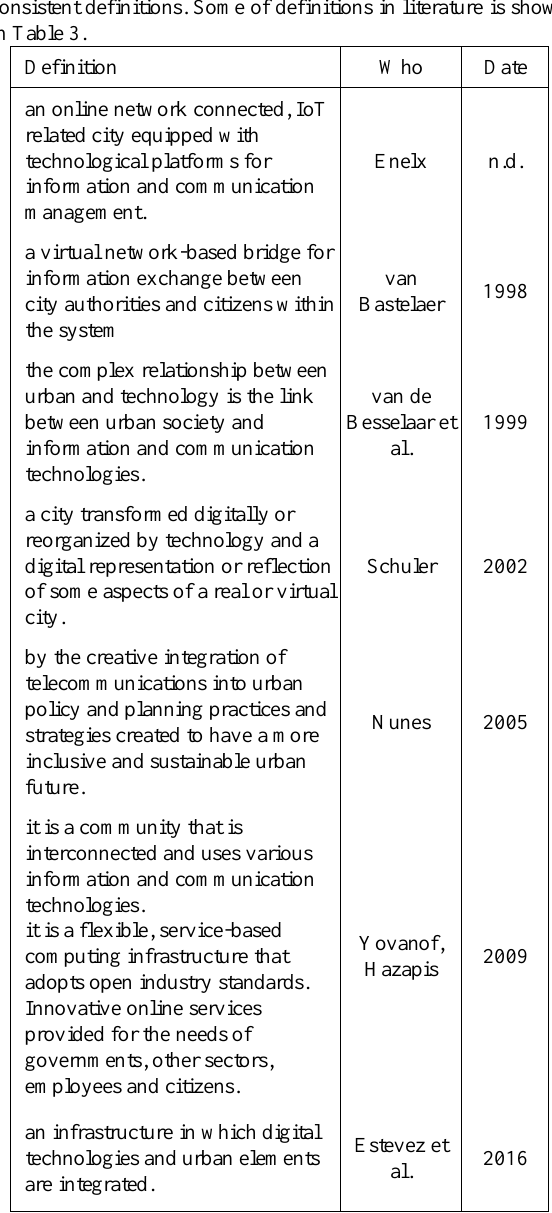
Table 3. Definitions in literature about digital cities However, some people define the term digital city as designing rhizome formations and creating organic forms in city silhouettes thanks to digital technologies, but this is a purely physical (Leach, 2009) digital city depiction and does not match the scope of this